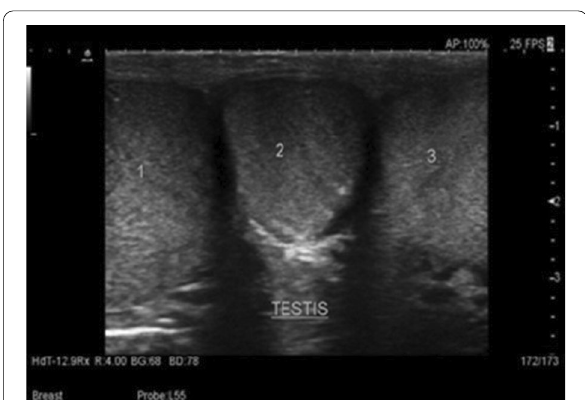
Fig. 2 Sonogram of scrotum demonstrating presence of extra